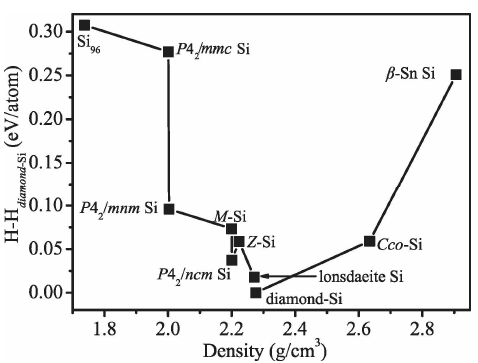
Figure 2. Calculated enthalpies of different silicon structures relative to the diamond Si at ambient pressure.